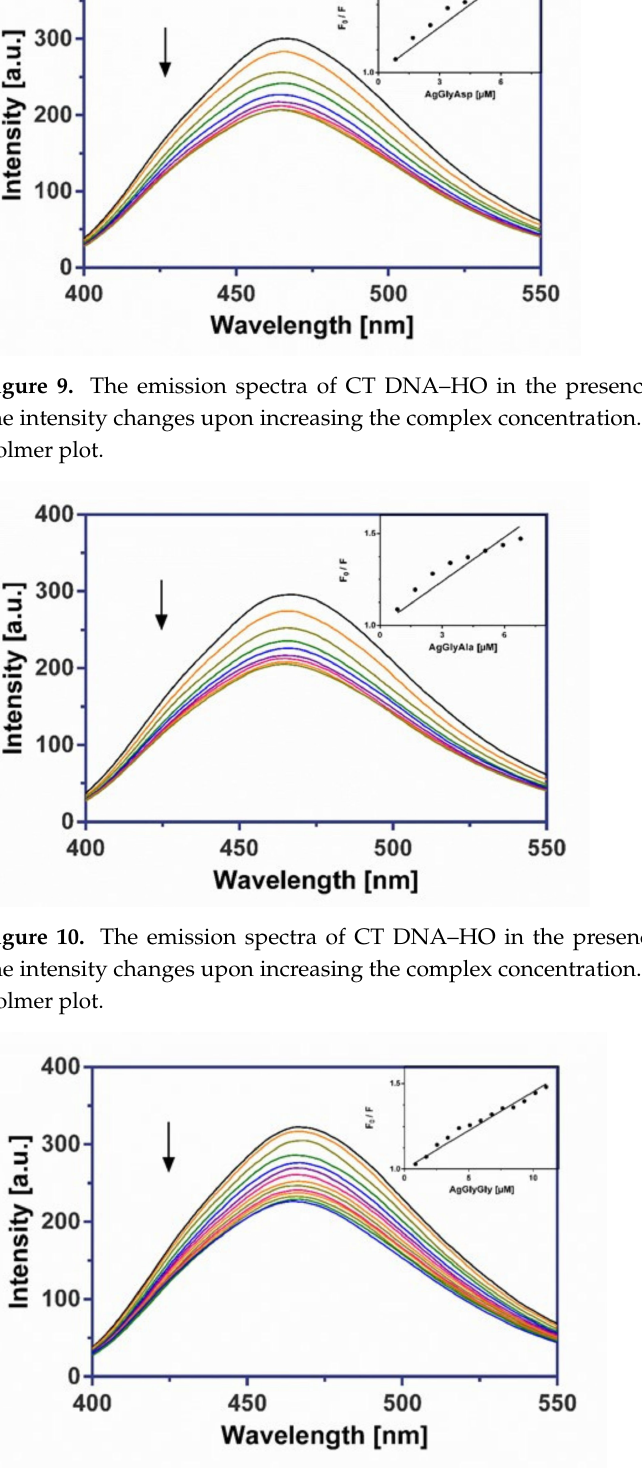
Figure 11. The emission spectra of CT DNA–HO in the presence of AgGlyGly. Arrow shows the intensity changes upon increasing the complex concentration. Inset: the corresponding Stern– Volmer